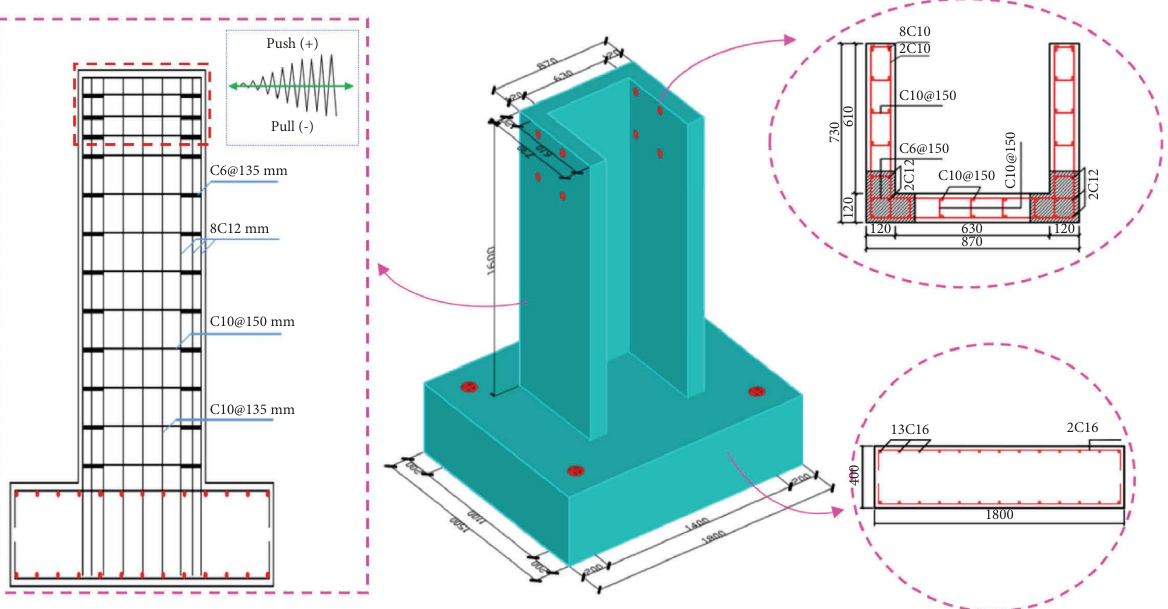
Figure 4: URC-X shear wall specimens and reinforcement diagram.